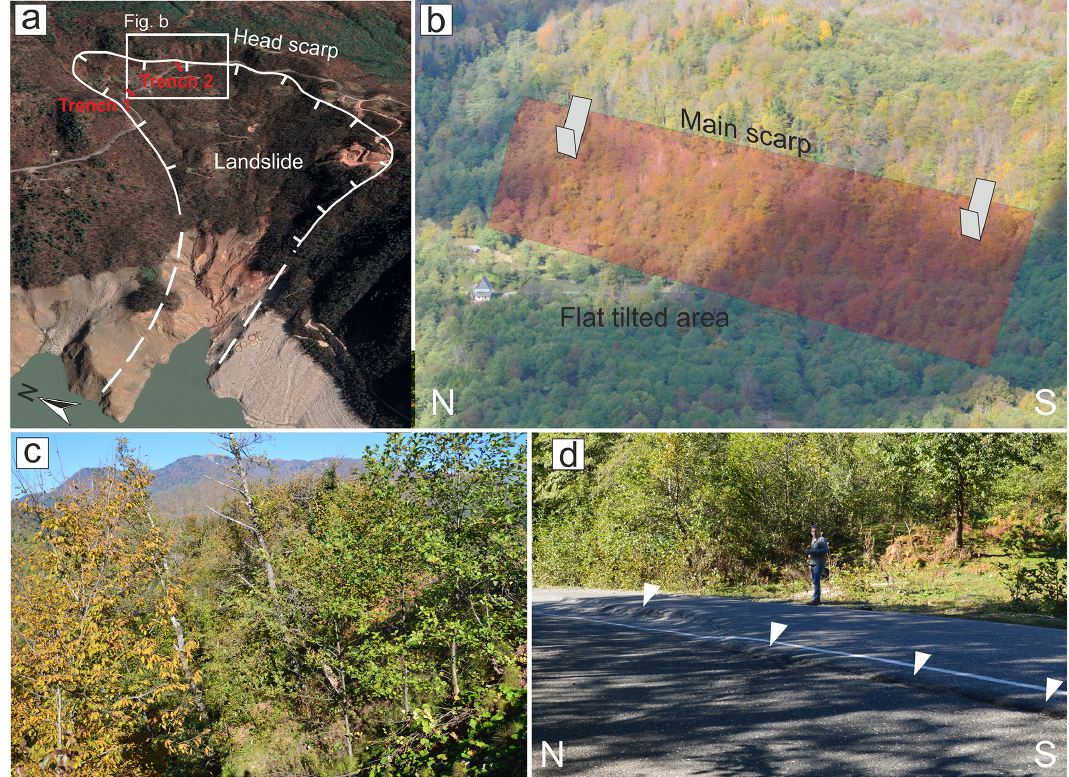
Figure 3. (a) Oblique view of the studied landslide (© Google Earth 2021); trench locations are shown. (b) Photo of a segment of the landslide head scarp; it is worth noticing the flat-lying area at the foot of the scarp, created by the uphill tilting of the slope during rotational movements of the landslide block. House for scale (left-hand side of the flat area). (c) Example of tilted trees along the landslide slope. (d) Photo of the escarpments cutting the Jvari–Khaishi–Mestia road (white triangles), representing the surface expression of active landslide slip planes.